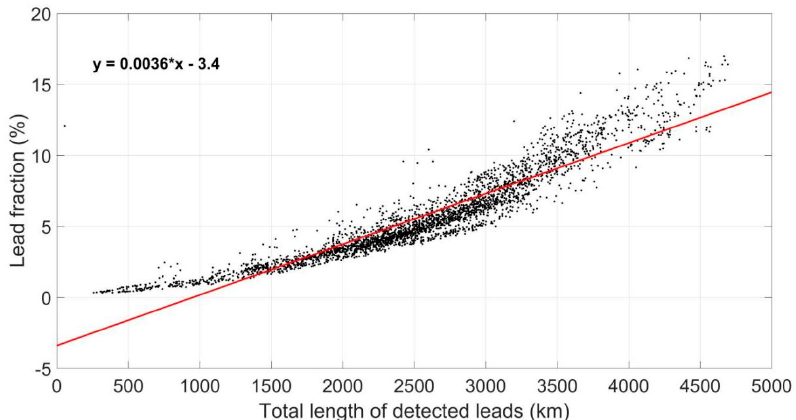
Figure 7. Correlation between sea ice lead fraction and total length of sea ice leads. Red line is a linear regression line with a fitting equation y = 0.0036x − 3.4.